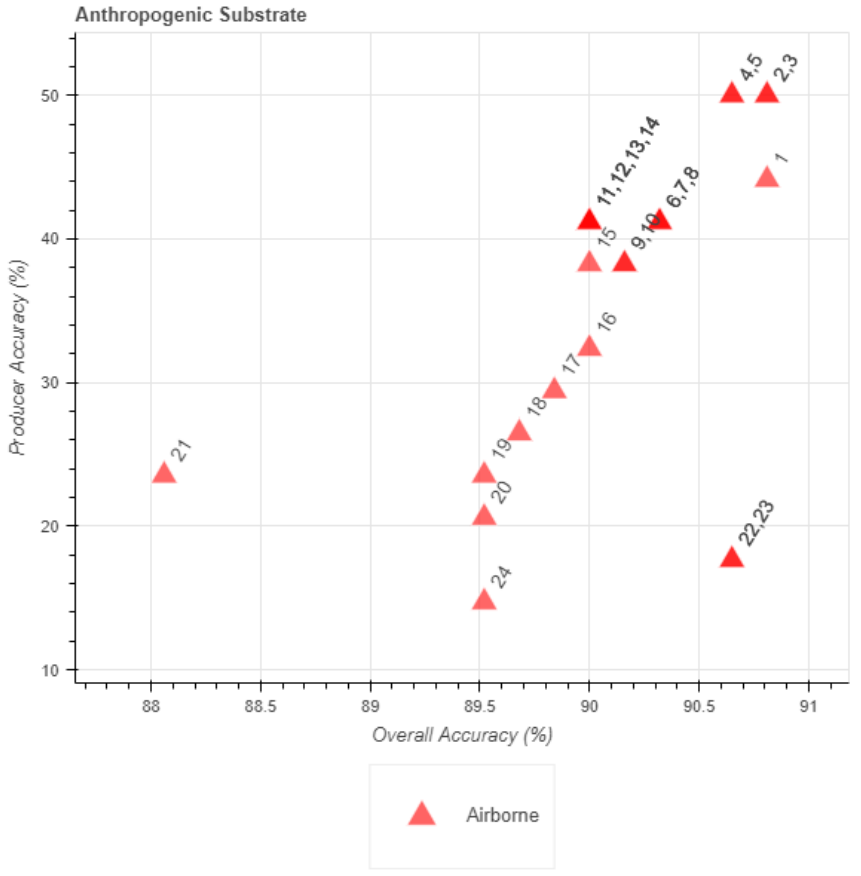
Figure 12. Tier 1 plot of anthropogenic substrate classification performance, comparing percent overall accuracy and percent producer accuracy for airborne only data combinations. Number labels refer to unique classification input data combinations identified in the Index field in Table A1, Appendix A. Note that satellite classification of anthropogenic substrates is not included because the satellite inputs were insufficient for discriminating those features.